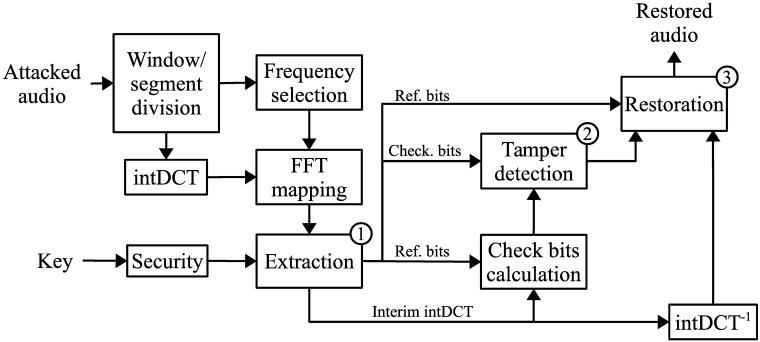
Block diagram of the decoding process.